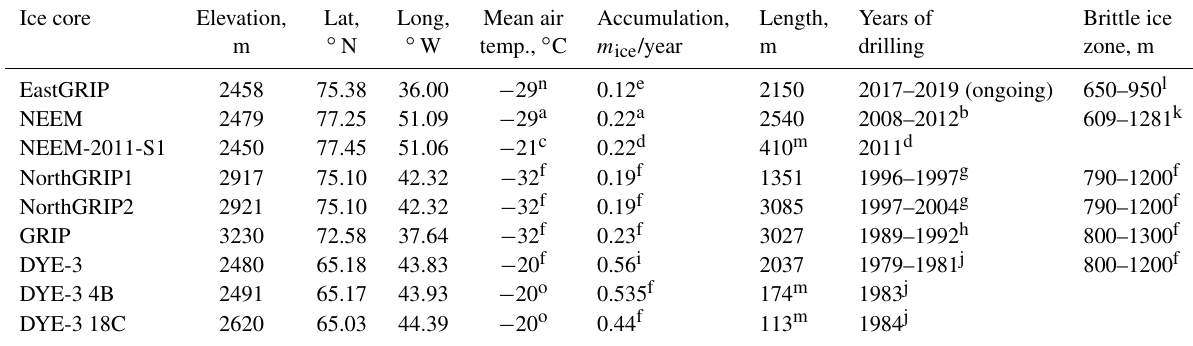
Table 1. Specifications about the ice cores included in this study.